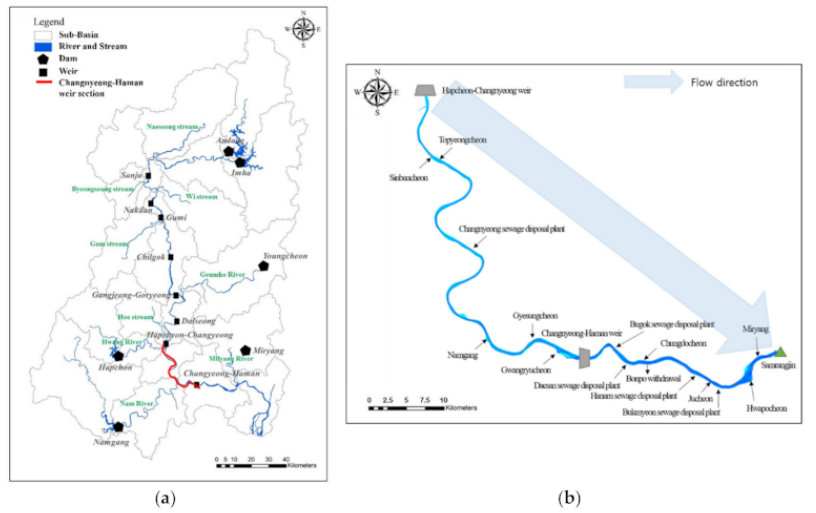
Figure 5. Study area: ( a ) Nakdong River Basin; ( b ) Hapcheon-Changnyeong weir-Changnyeong- Haman weir section.